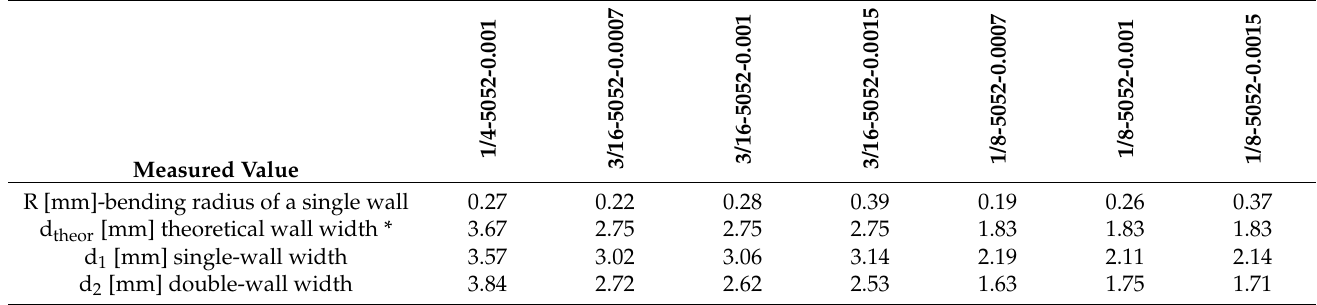
Figure 6. Examples of the measurement results of the geometrical parameters of the actual cores. The results of the geometric measurements, averaged for individual samples, are presented in Table 2. Table 2. List of characteristic dimensions obtained by measuring actual structures.